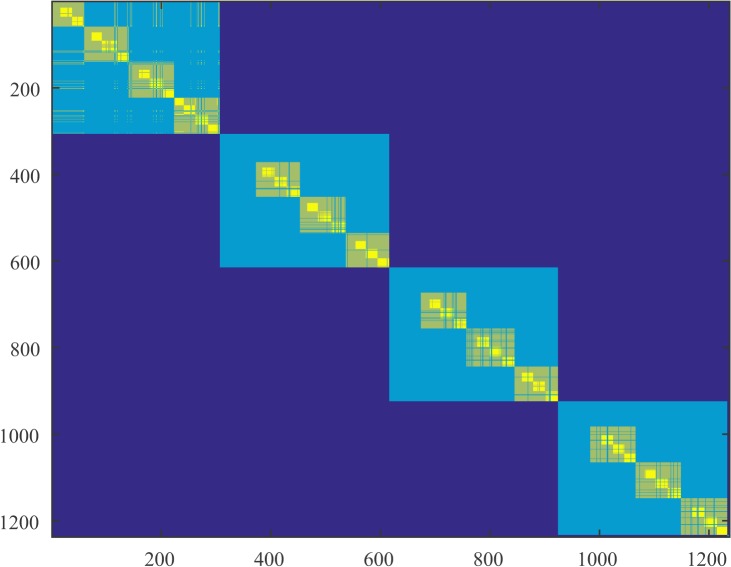
Modified co-affinity matrix during symbol arrangement.Modified co-affinity matrix while the subject was exposed to the arrangement of symbols that was connected with the question in the first epoch. The segmentation of the block diagonal organization seems to be segmented in this time frame too.